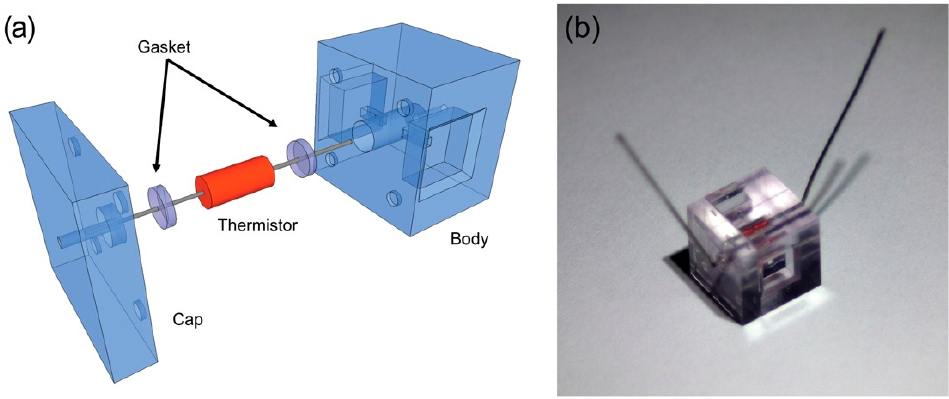
Figure 1. ( a ) Exploded-view Computer Aided Design (CAD) model, depicts the insertion of a radial-style thermistor inserted into a microchannel element through a single face and sealed by polydimethylsiloxane (PDMS) gaskets with two slits for electrical leads; ( b ) Assembly of the device demonstrated in this work.